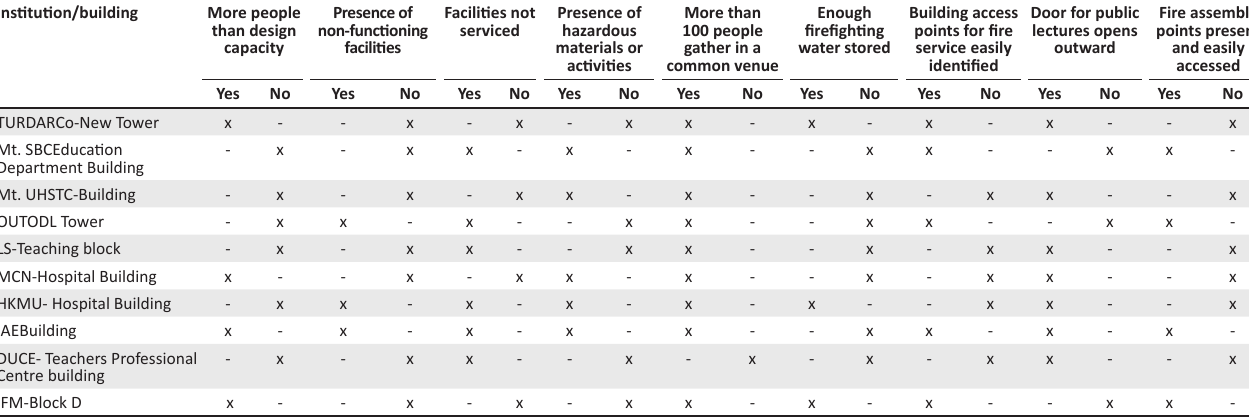
TABLE 5: Fire hazard indicators for